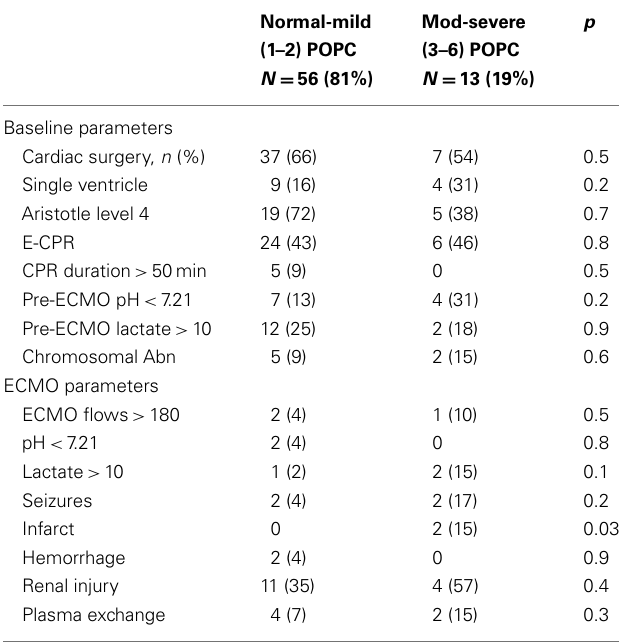
Table 8 | Comparison of patients with good – mild